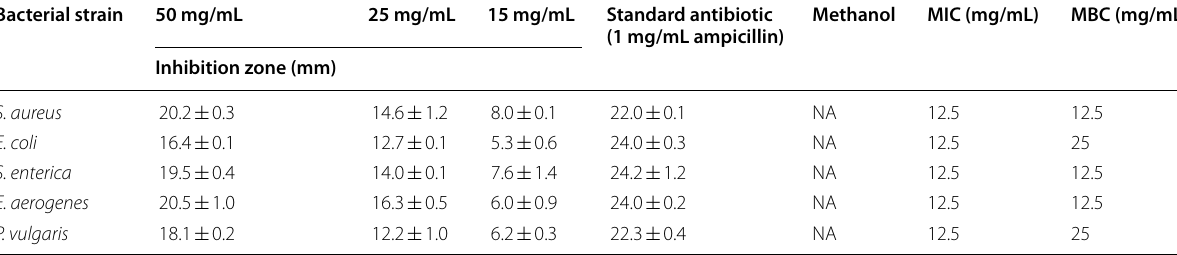
Ampicillin: positive control, and methanol: negative control. NA no activity